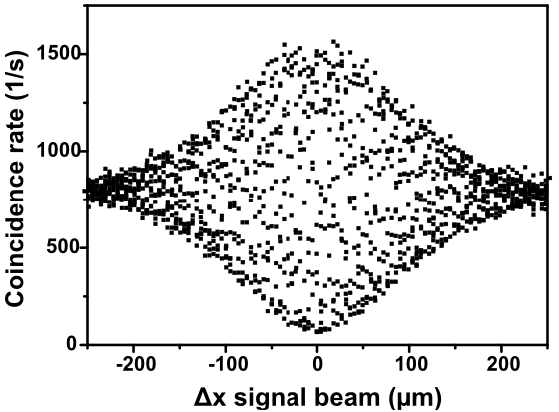
Figure 2. Counting rate for single signal photons at Detector A in coincidence with single idler photons at Detector B as a function of the signal path delay (see Figure